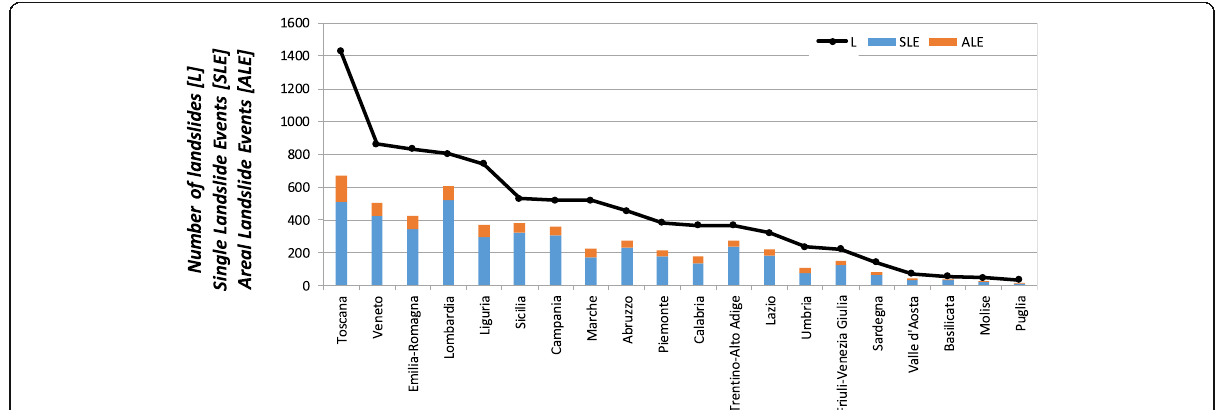
Fig. 4 Number of single landslide events (SLE), areal landslide events (ALE) and landslides (L) in the 20 Italian regions, ordered by decreasing number of